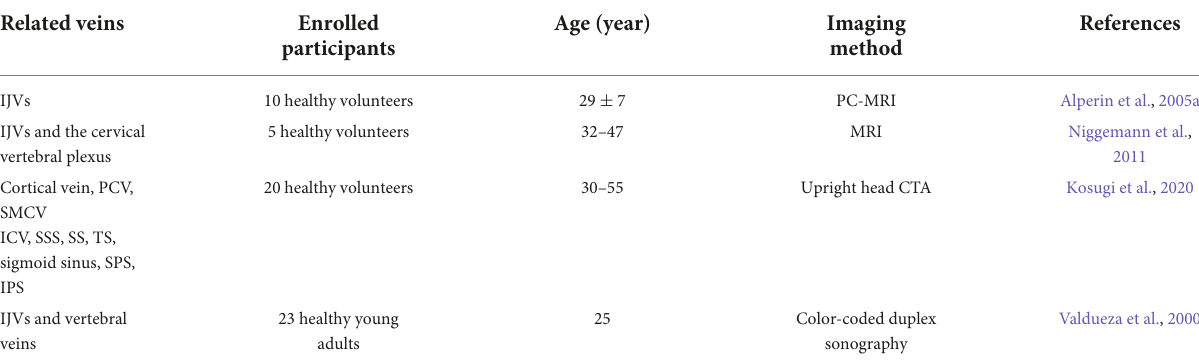
TABLE 6 Posture-induced imaging changes in cerebral veins and venous sinuses. Related